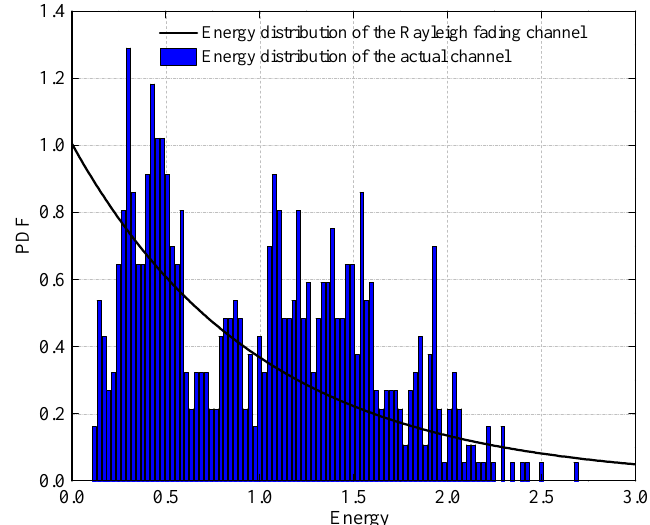
Figure 11. Normalized energy distribution of the actual